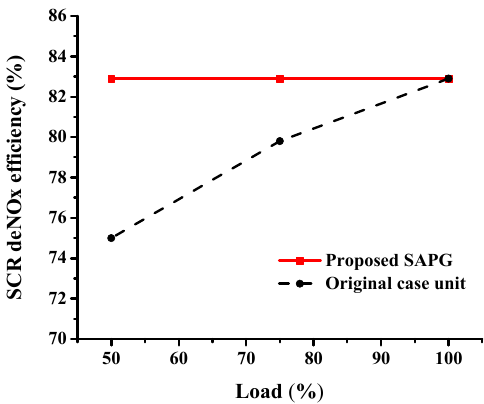
Figure 8. Comparison of the SCR de-NO x efficiency in the proposed SAPG and original case unit.